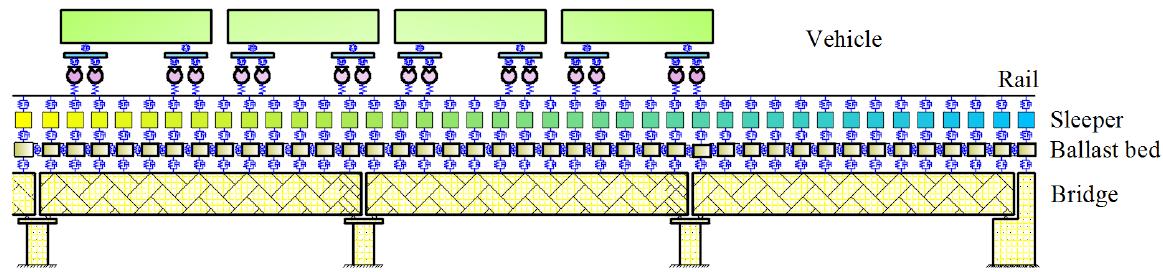
Figure 3. Vehicle – track – bridge dynamic simulation model. Figure 3. Vehicle–track–bridge dynamic simulation